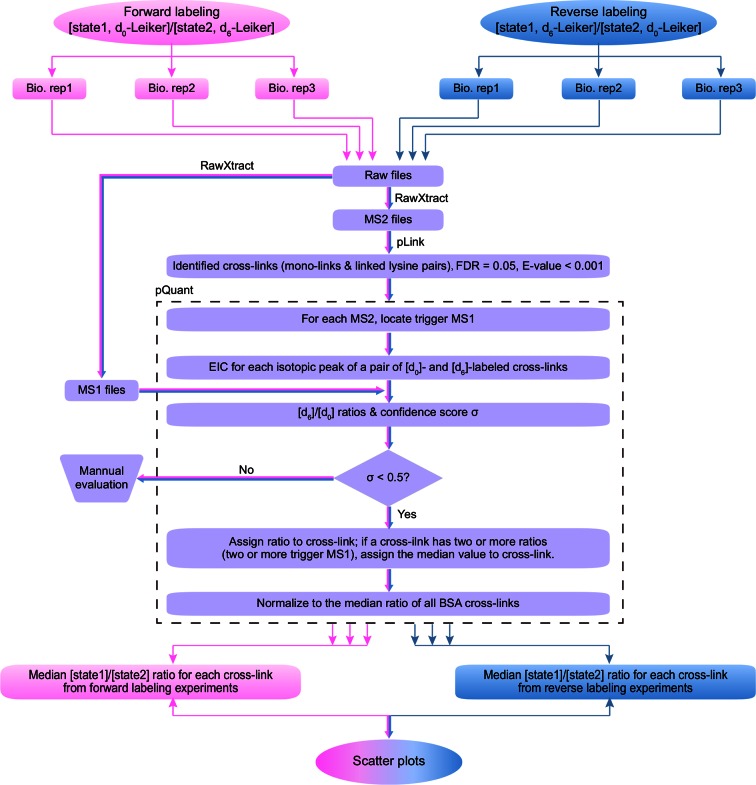
Workflow for quantification of cross-linked peptides using pQuant.For each identified cross-link spectrum, an extracted ion chromatogram (EIC) is constructed for each isotopic peak of the [d0]- and [d6]-labeled precursor. The [d6]/[d0] ratios can be calculated based on the monoisotopic peak, the most intense peak, or the least interfered peak of each isotopic cluster as specified by users. The accuracy of the ratio calculation was evaluated with the confidence score σ (range: 0–1, from the most to the least reliable). If a cross-link have ratios with σ < 0.5, the median of these ratios is assigned to this cross-link. The cross-link ratios of the proteins of interest are normalized to the median ratio of all BSA cross-links. For each cross-link, the median [state1]/[state2] ratio of three independent forward labeling experiments is plotted against the median ratio of three independent reverse labeling experiments. Cross-links that are only present in state1 or state2 due to a dramatic conformational change cannot be quantified as described above because the ratios would be zero or infinite and their σ values would be 1. Therefore, if a cross-link does not have a valid ratio after automatic quantification, the EICs were manually inspected to determine if it was an all-or-none change.